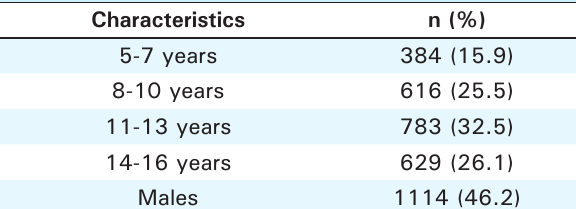
Table 1. Distribution of students by age group and